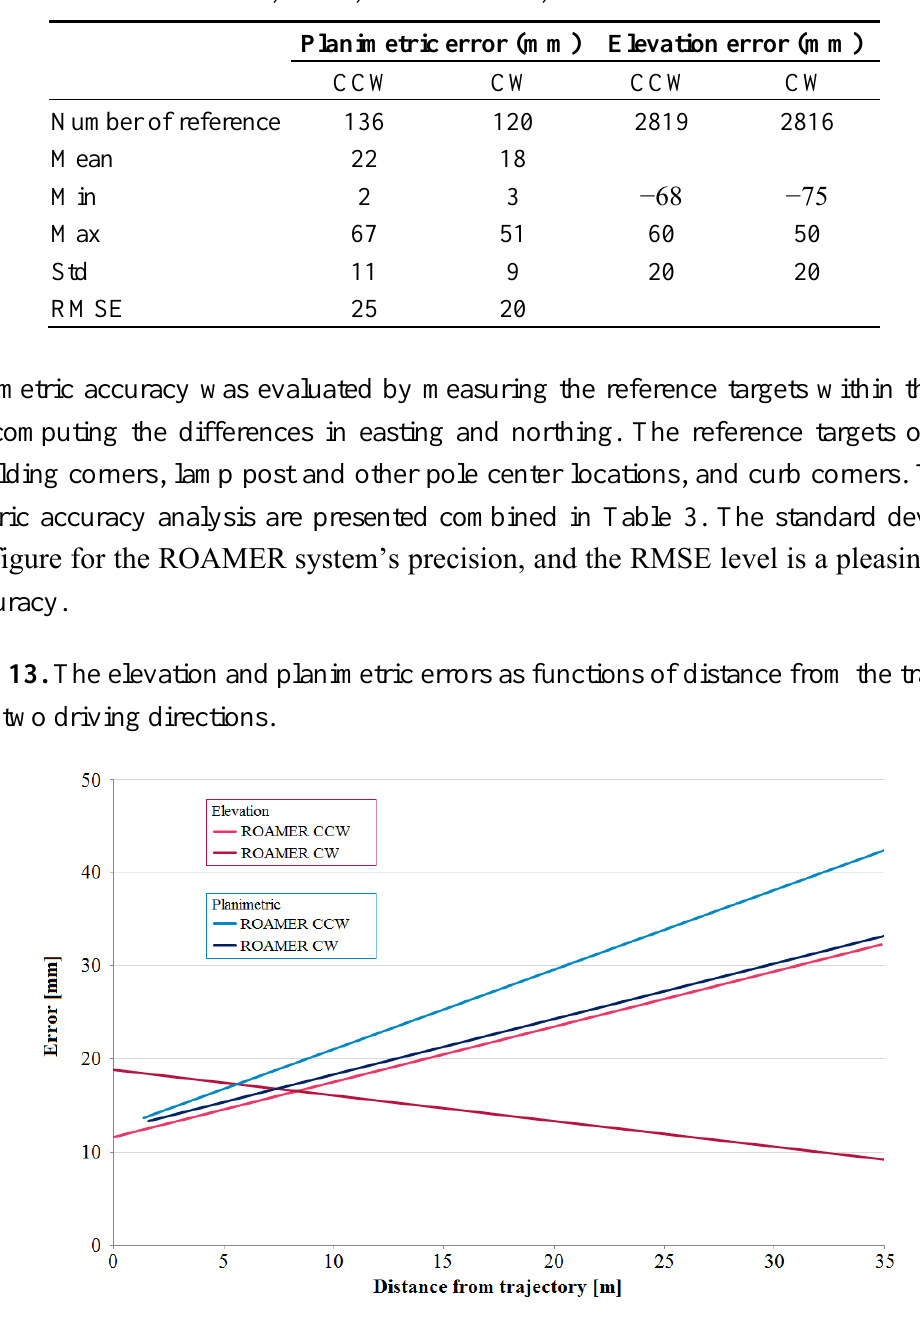
Table 3. Planimetric and elevation error values for the ROAMER MLS data. Driving directions: counter-clockwise, CCW, and clockwise, CW.